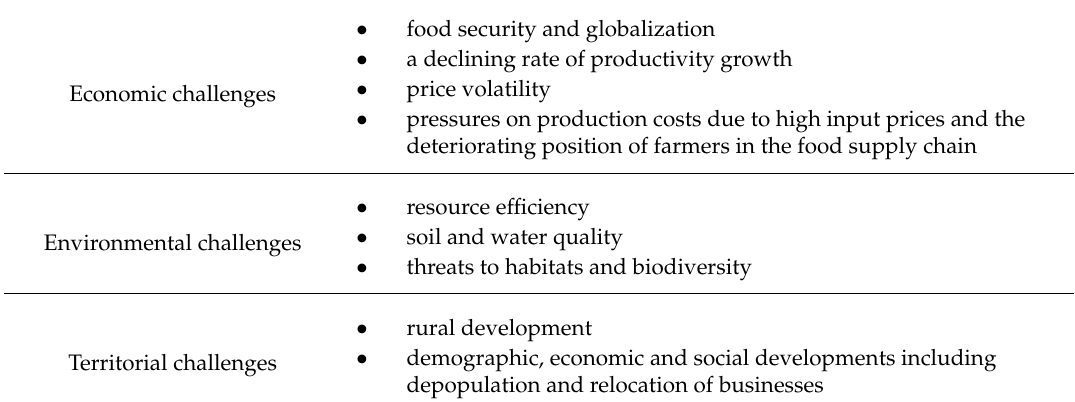
Table 1. Challenges in the agricultural sector